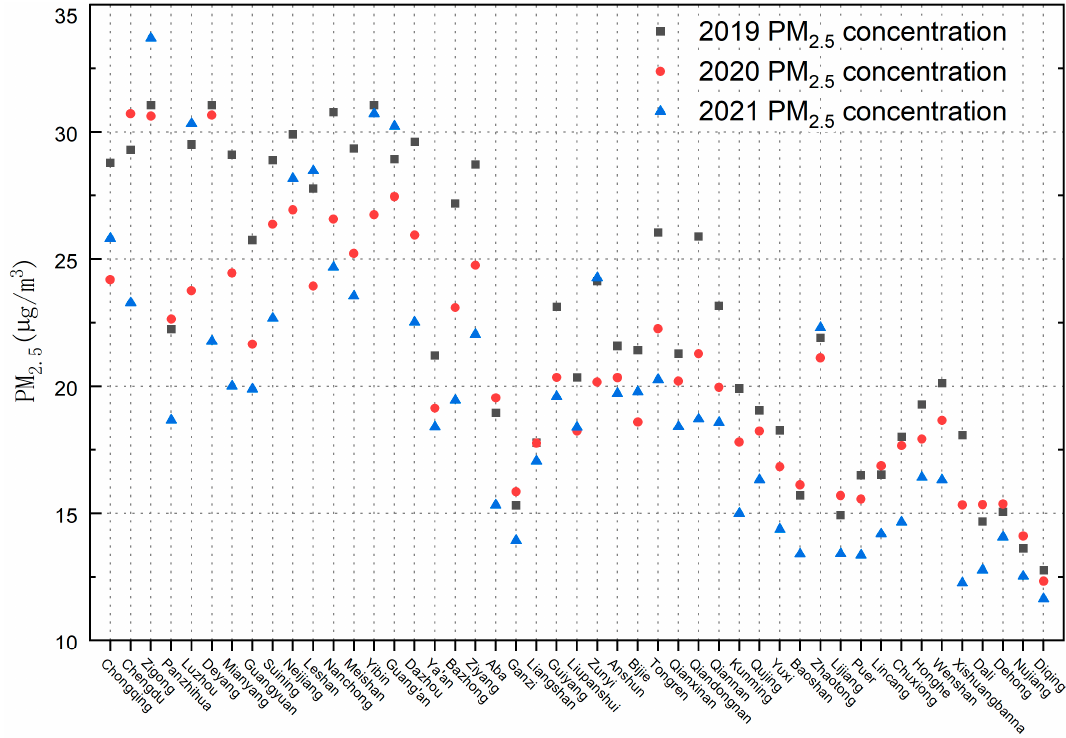
Figure 10. Changes in PM 2.5 concentrations in cities of southwest China in autumn.